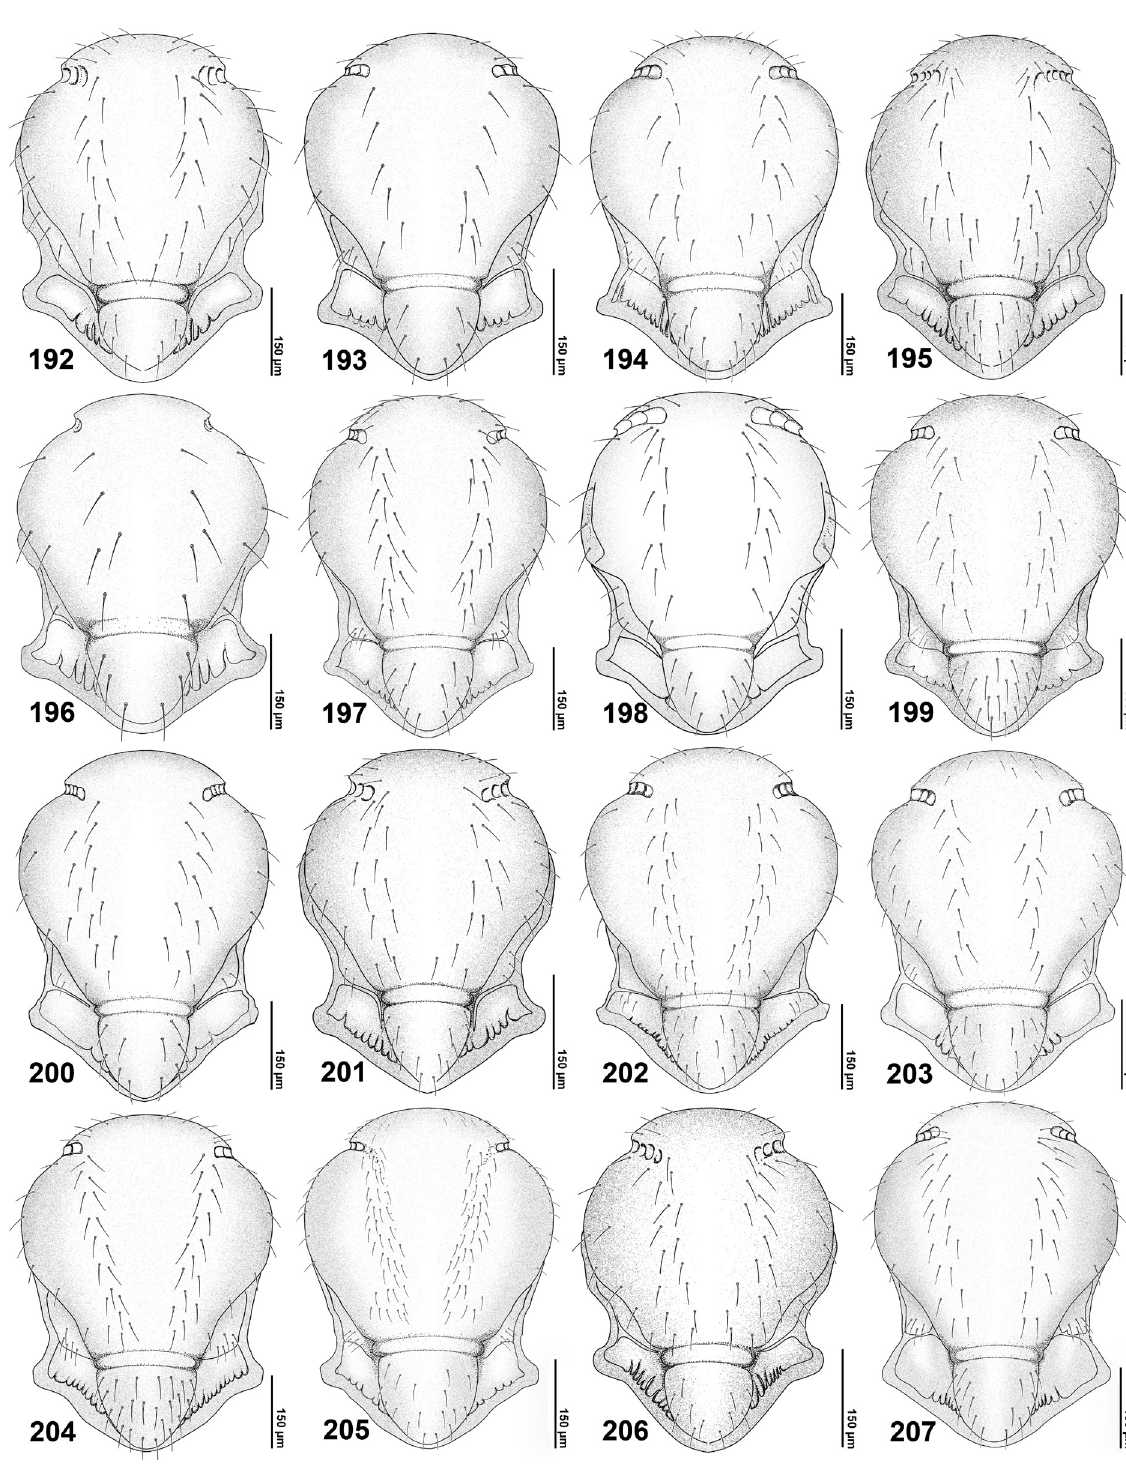
Figs 192–207. Dorsal aspect of mesonotum (♀): 192 . Aphidius hieraciorum . 193 . Aphidius iranicus . 194 . Aphidius matricariae . 195 . Aphidius microlophii . 196 . Aphidius myzocallidis . 197 . Aphidius persicus . 198 . Aphidius platensis . 199 . Aphidius popovi . 200 . Aphidius rhopalosiphi . 201 . Aphidius ribis . 202 . Aphidius rosae . 203 . Aphidius salicis . 204 . Aphidius setiger . 205 . Aphidius smithi . 206 . Aphidius sonchi . 207 . Aphidius stigmaticus